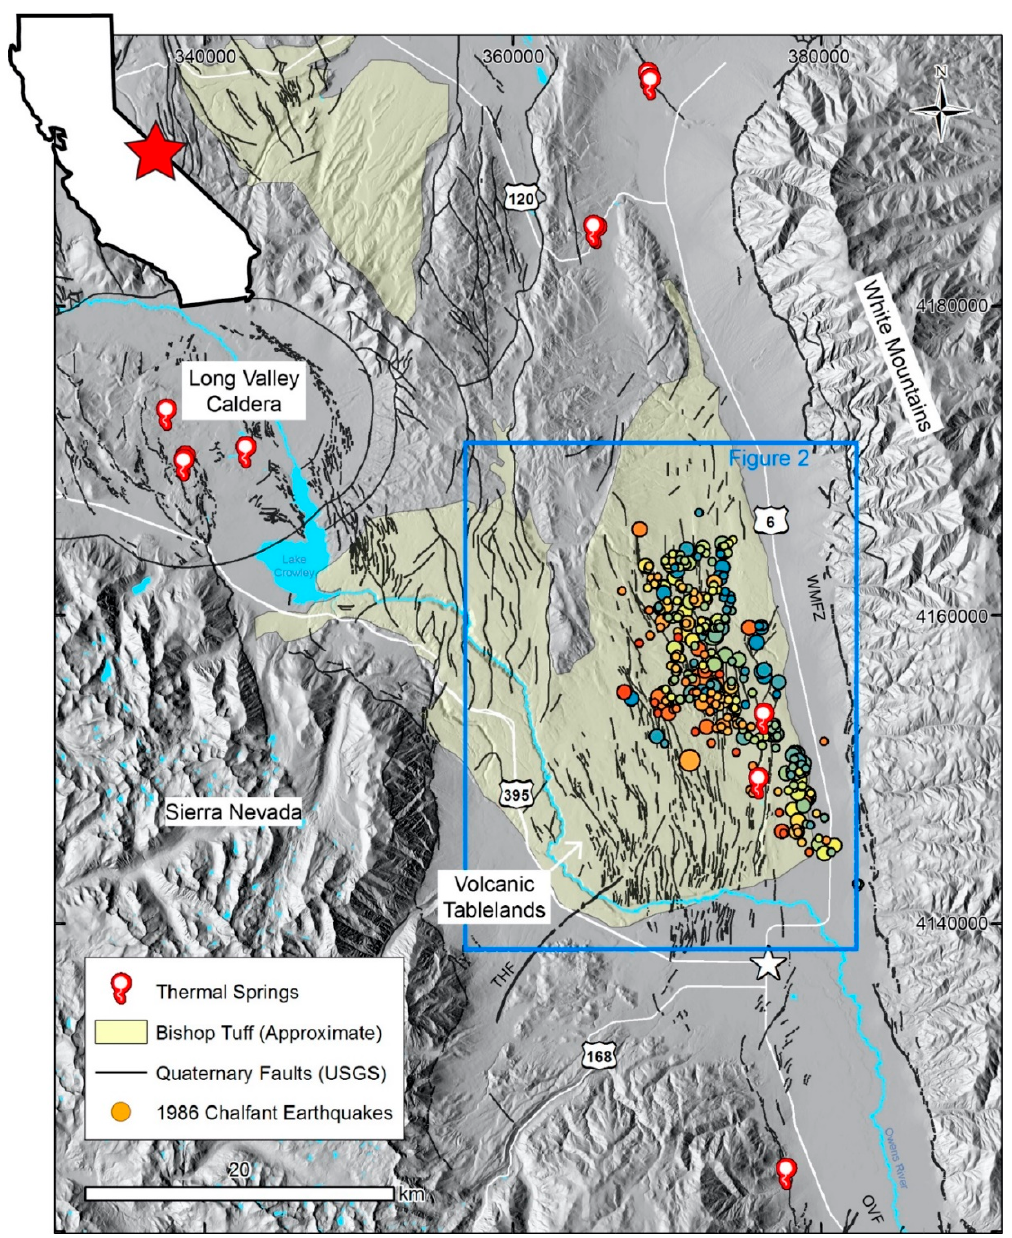
Figure 1. Geographic overview of northern Owens Valley, with its location in California shown in upper left corner, shown as a hillshade map with westward illumination in Universal Transverse Mercator projection (UTM zone 11N). The map highlights the extent of the Bishop Tuff (approximated after Luedke and Smith [19]), quaternary faults plotted from the USGS fault database, and active thermal springs. Please note locations of the White Mountain Fault Zone (WMFZ), Owens Valley Fault (OVF), and Tungsten Hills Fault (THF) as major structures of the area. The epicenters from the 1986 Chalfant Earthquake Sequence are shown as colored circles, with circle sizes representing earthquake magnitude and colors representing depth. Smallest circles represent Magnitudes 3 whereas the largest circles show the events exceeding Magnitudes 6. Blue circles show the shallowest quakes at depths around ~0.8 to 3.8 km whereas red circles indicate the deepest quakes at 8.6 to 15 km. The town of Bishop is indicated by the white star.